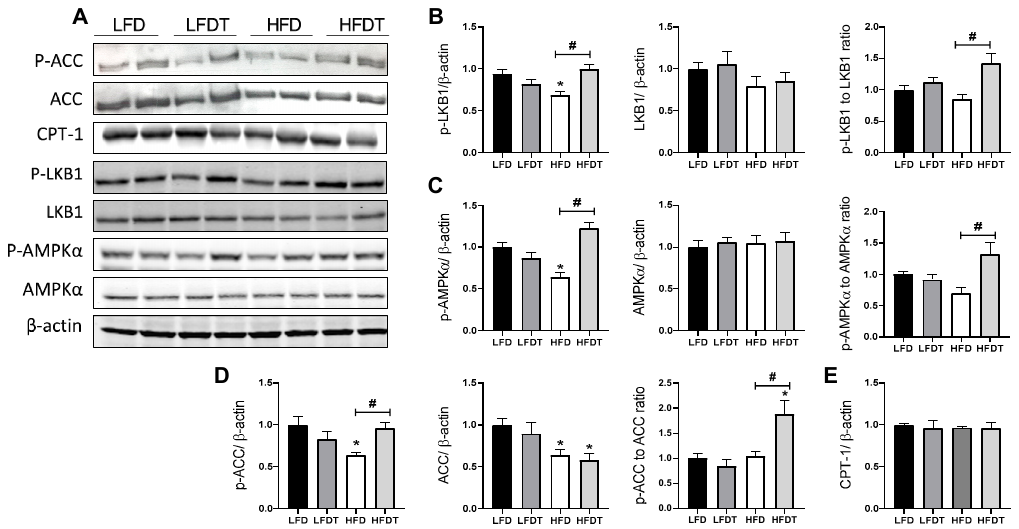
Figure 6. Delayed EET restores AMPK activity in the kidney of HFD mice. ( A ) Western Blot analysis of phosphor-LKB1, LKB1, phospho-AMPK, AMPK, phospho-ACC, ACC and CPT-1 in kidney tissue from mice on LFD, LFDT, HFD and HFDT at week 20. ( B ) Relative densitometry of the immunoblots representing, respectively, phospho-LKB1 protein level normalized with β -actin, LKB1 protein level normalized with β -actin and phospho-LKB1 to LKB1 ratio. ( C ) Relative densitometry of the immunoblots representing, respectively, phospho-AMPK protein level normalized with β -actin, AMPK protein level normalized with β -actin and phospho-AMPK to AMPK ratio. ( D ) Relative densitometry of the immunoblots representing, respectively, phospho-ACC protein level normalized with β -actin, ACC protein level normalized with β -actin and phospho-ACC to ACC ratio. ( E ) Relative densitometry of the immunoblots representing CPT-1 protein level normalized with β -actin. Statistical analyses were performed by one-way ANOVA followed by Newman–Keuls post hoc test. Data are presented as means ± SEM. * p ≤ 0.05 versus LFD # p ≤ 0.05 versus HFD. n = 6–8 in each group.